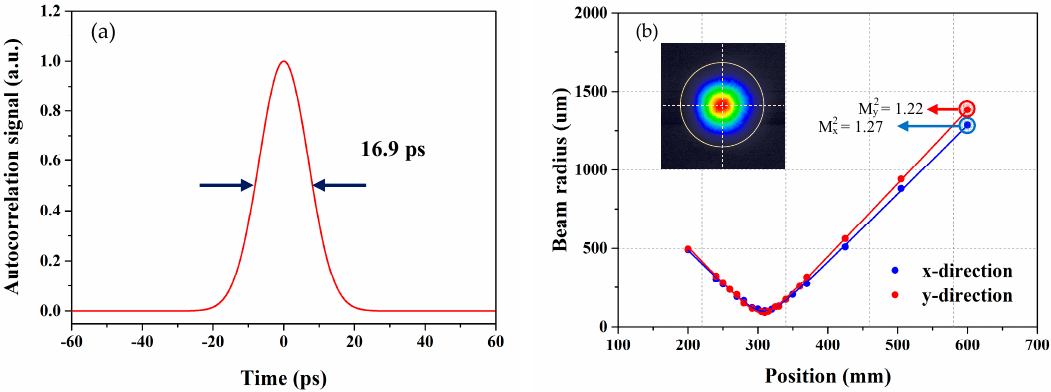
Figure 4. Measured ( a ) autocorrelation trace (Gaussian fitting) for the amplified pulse; and ( b ) beam quality factor M 2 (insert: near-field beam intensity distribution).